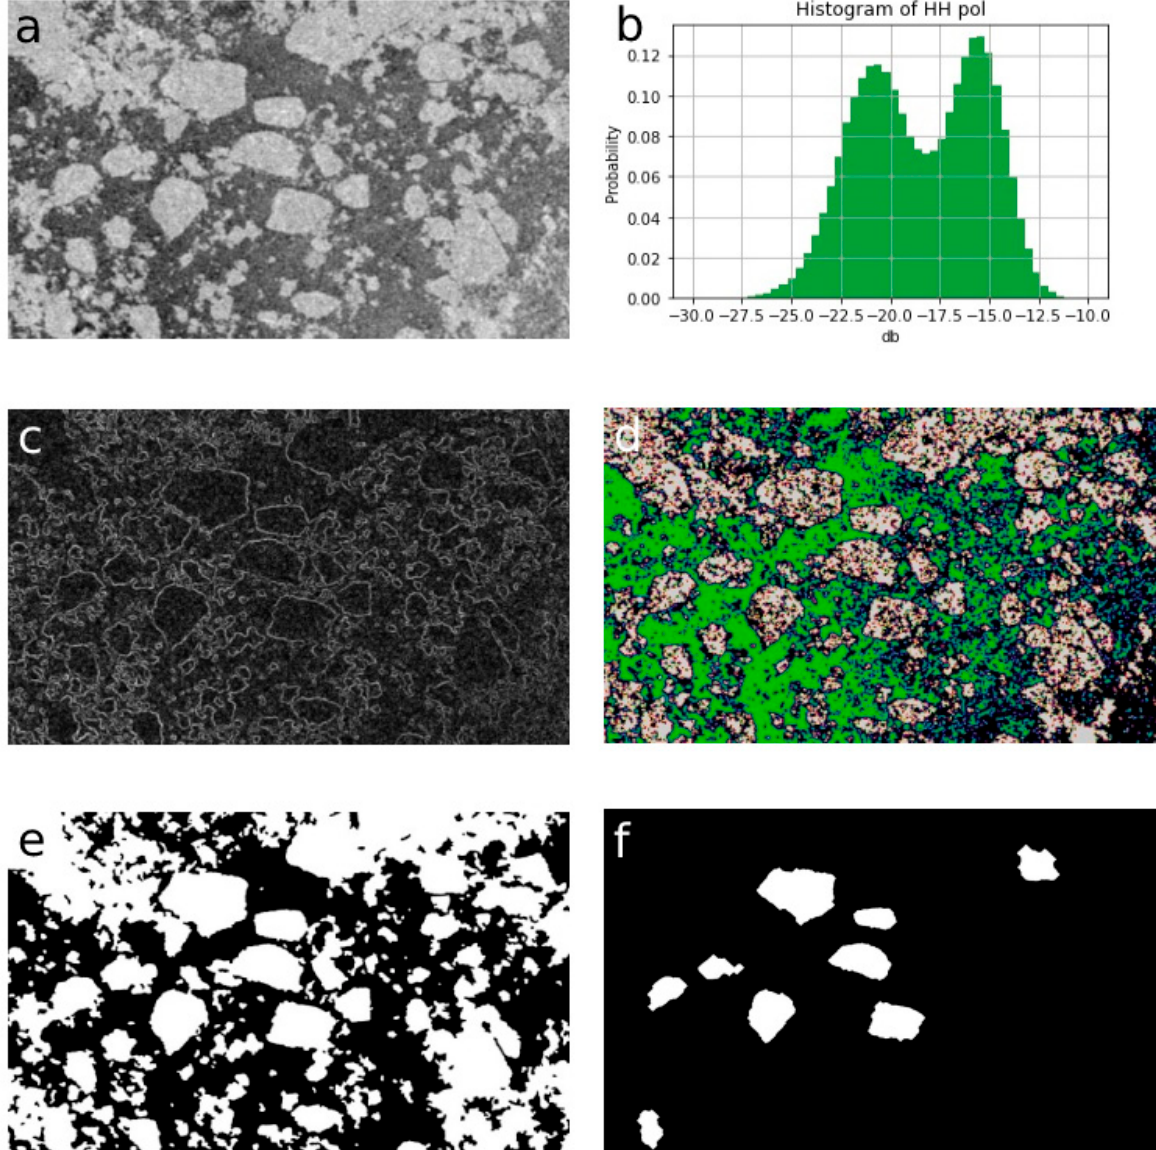
Figure 4. ( a ) S-1 HH image subset of 30. July 2019; ( b ) histogram of S-1 HH image subset; ( c ) elevation map of Sobel gradient; ( d ) water (green color) and floe (white color) markers for watershed transform; ( e ) segmentation result; ( f ) segmentation result after morphology processing.